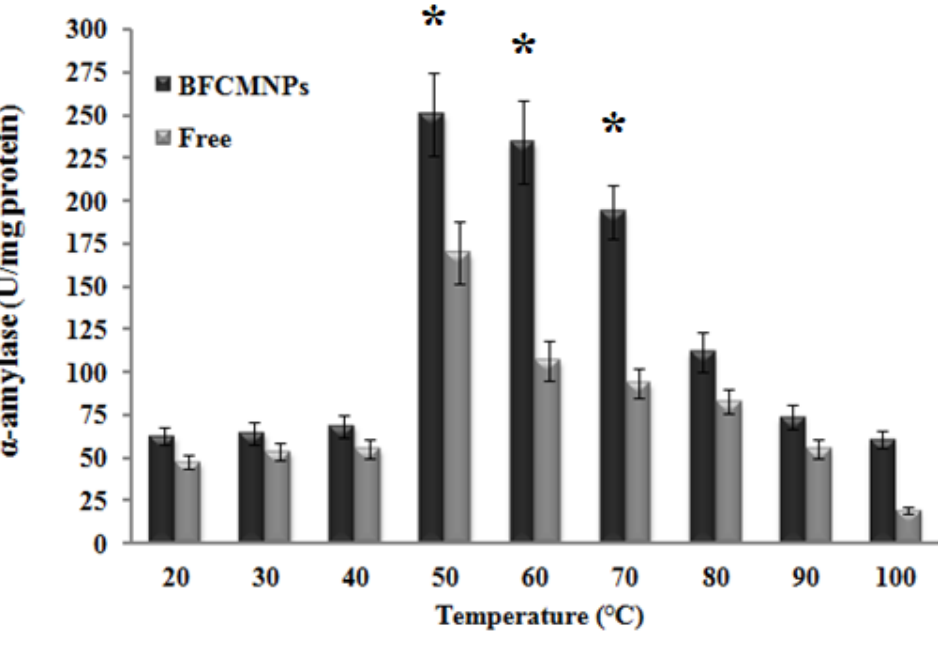
Figure 10. Effect of temperature on the specific activity of free and immobilized alpha-amylase-BFCMNPs; * p ≤ 0.05.